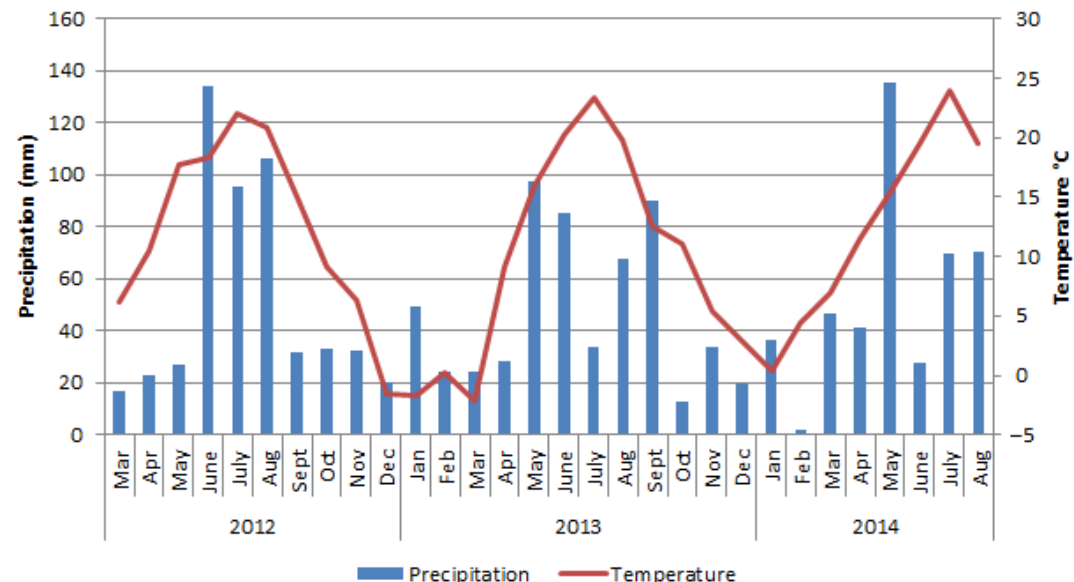
Figure 3. The distribution of rainfall and mean temperatures during the field experiment in D ł o ń , Poland.